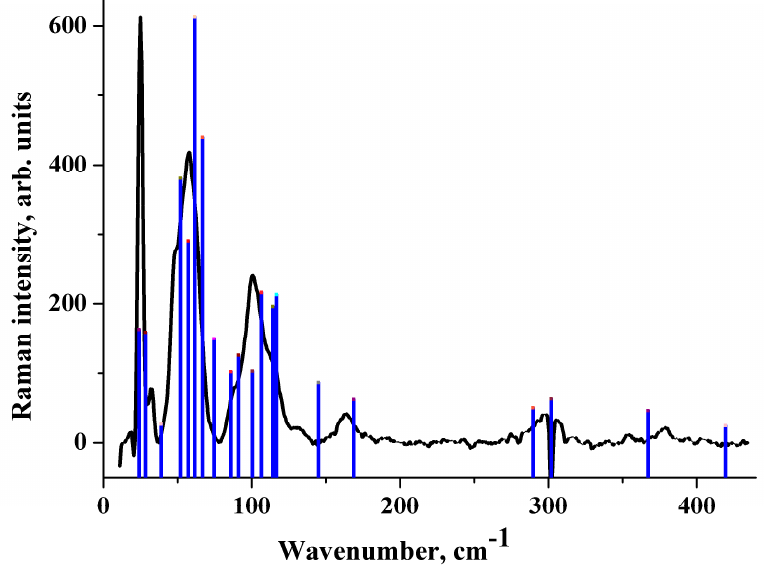
Figure 6. Raman spectrum of [CRB + MLE] (1:1). Experiment (black line) vs. PBE-D3(AtomOnly) computations (blue bars). The height of the bars is proportional to the relative Raman intensity of the corresponding transition.